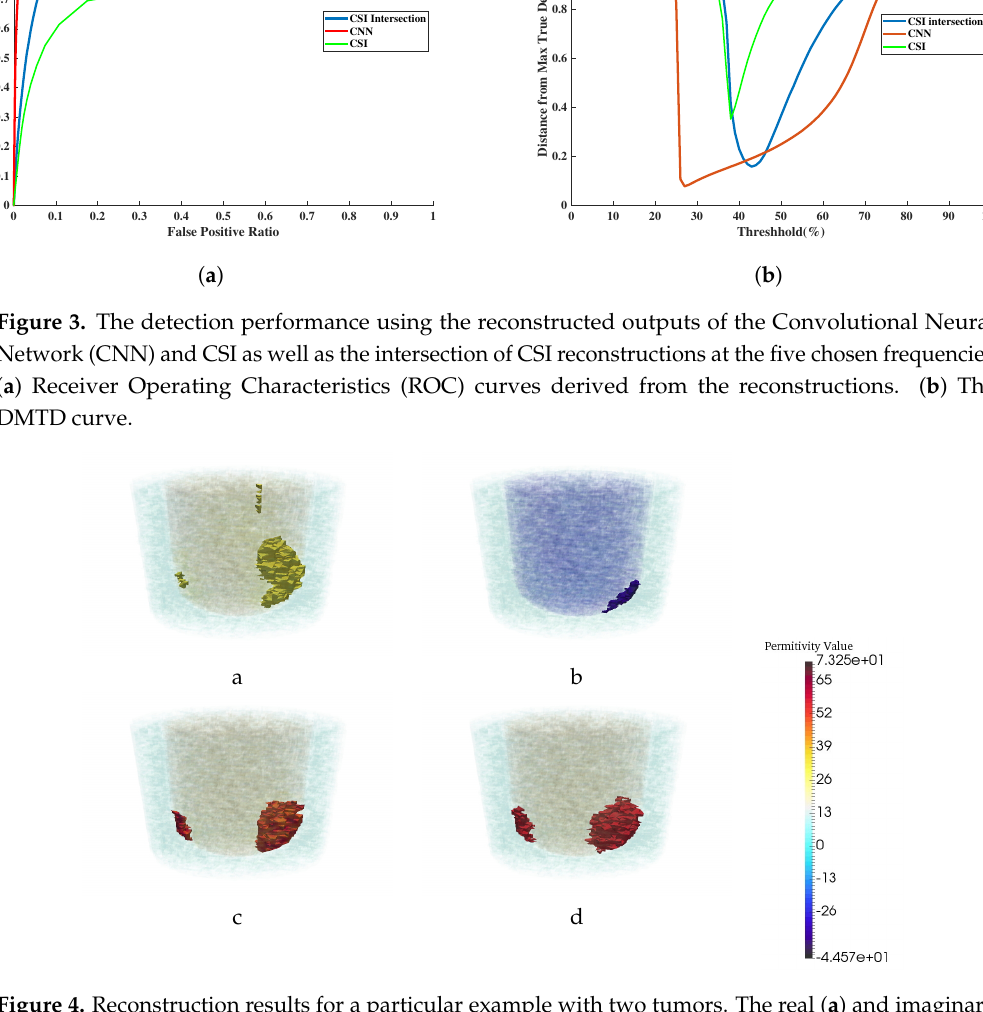
Figure 4. Reconstruction results for a particular example with two tumors. The real ( a ) and imaginary ( b ) part of CSI reconstruction at 1.1 GHz. ( c ) CNN reconstruction. ( d ) Ground truth. Table 2. Comparison of reconstruction and tumor detection